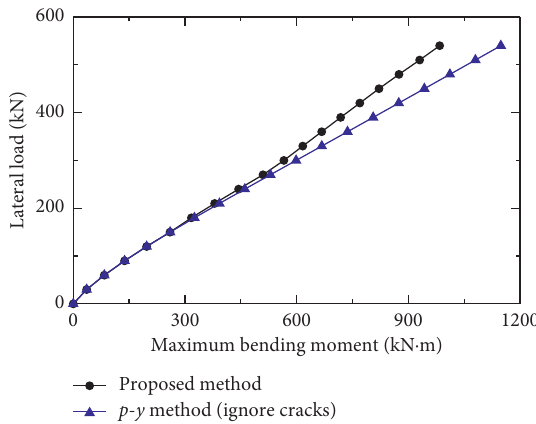
Figure 8: Load-maximum bending moment